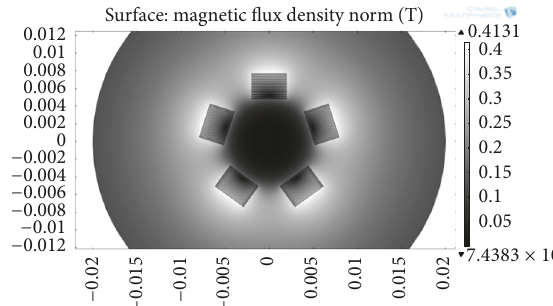
Figure 4: Contour plot in gray scale of the magnetic field intensity for the 30 tapes, 5 slots’ original configuration [4] in self-field operating